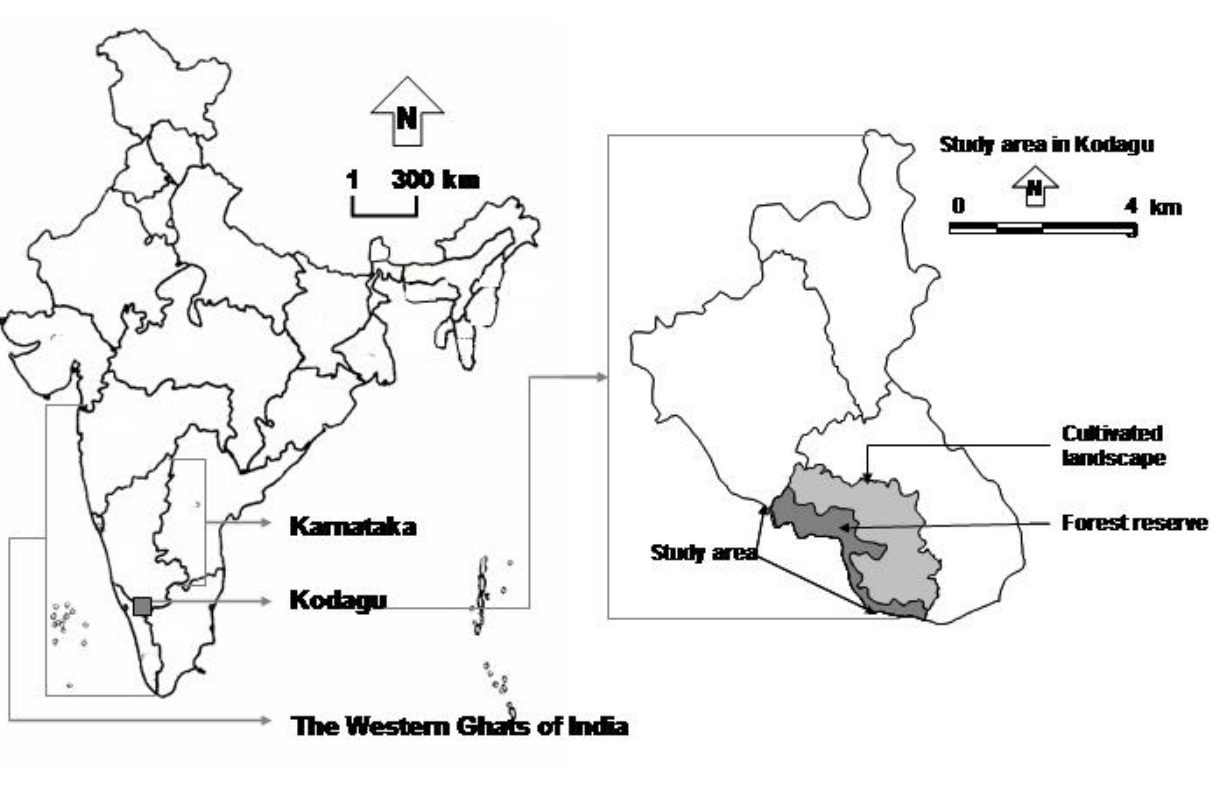
Fig. 1. The study area, showing Kodagu District in Karnataka State, India; sampling sites were located in the southwestern part of the district, where the continuous forest reserve adjoins cultivated landscape consisting of coffee plantations, and sacred